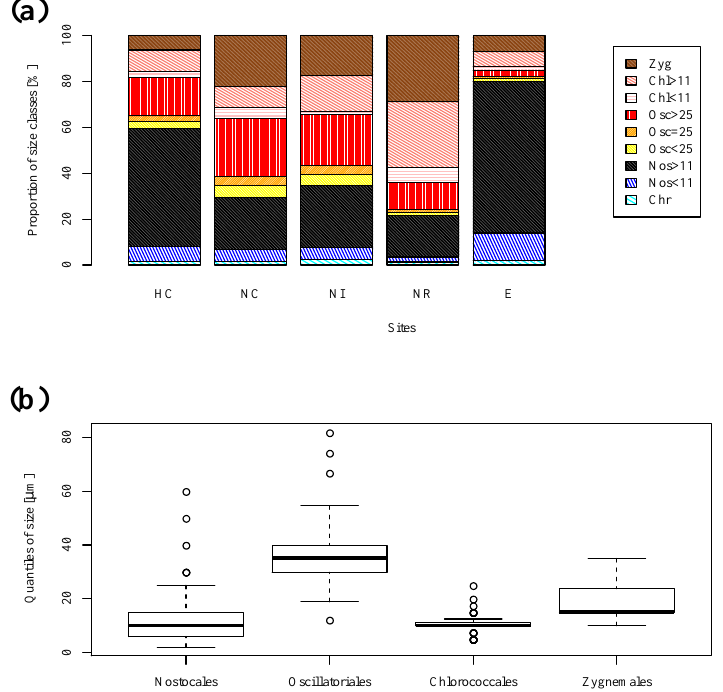
Figure 4. (a) Median and quantiles of the biovolume proportion of suggested size classes and (b) the cell number proportion of the median length (Zygnemales), diameter (Chlorococcales), colony size (Nostocales), and mean length (Oscillatoriales) as smaller (<) or bigger (>) than a certain threshold in micrometers. The abbreviations used in (a) refer to Chroococcales (Chr; may include single-cell Nostocales), Nostocales (Nos), Oscillatoriales (Osc), Chlorococcales (Chl), and Zygnemales (Zyg).